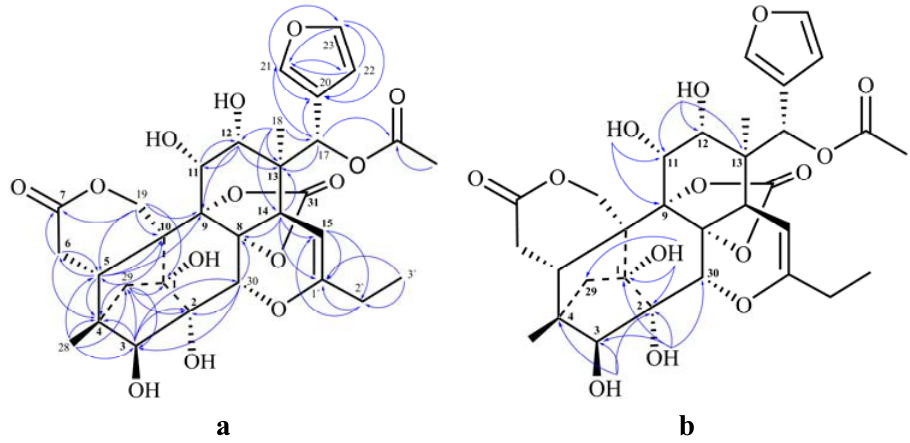
Figure 2. HMBC correlations of compound 1 . ( a ) carbon skeleton ( b ) hydroxyl groups.